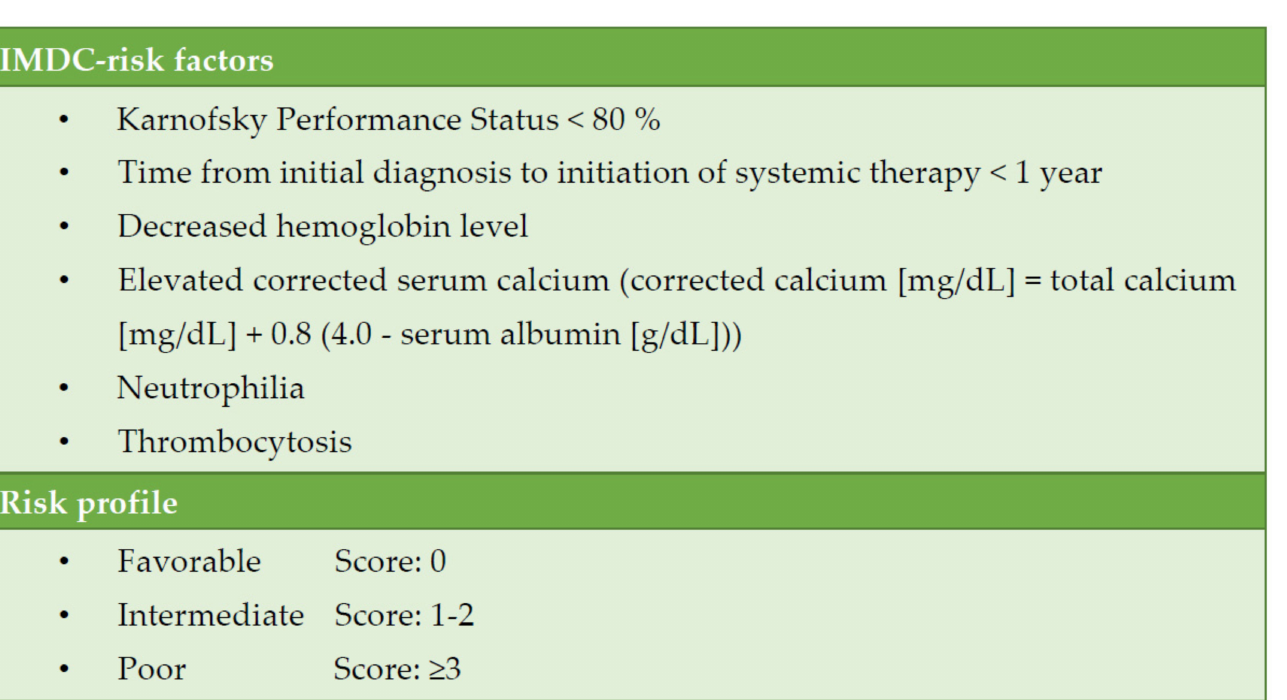
Figure 1. Risk assessment for metastatic renal cell carcinoma according to the International Metastatic RCC Database Consortium